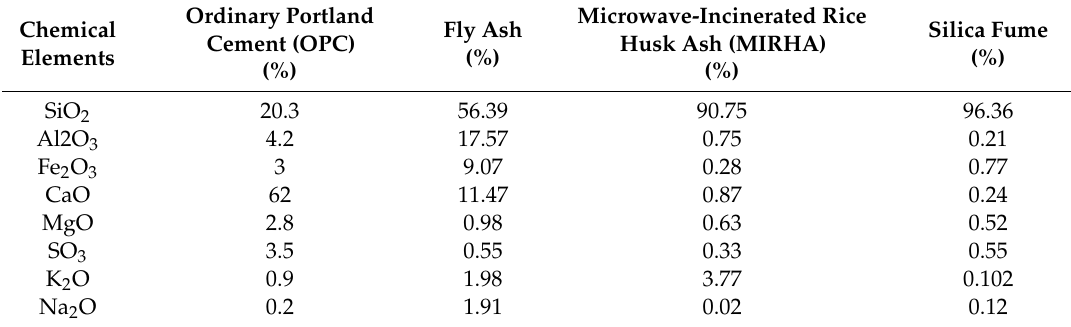
Table 1. Chemical characteristics of